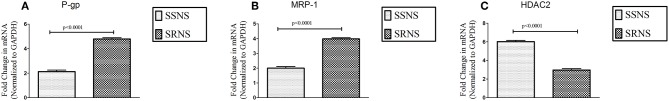
Expression of P-gp, MRP-1 and HDAC2 on unstimulated PBMCs of SRNS and SSNS patients. Peripheral Blood Mononuclear Cells were isolated from SRNS and SSNS patients and the mRNA levels of P-gp, MRP-1 and HDAC2 were quantified by real-time PCR technique (A–C). The experiments are representative of three independent series. Pooled data of all the experiments are represented as mean ± SEM. Significant differences compared to control were indicated by p < 0.05.